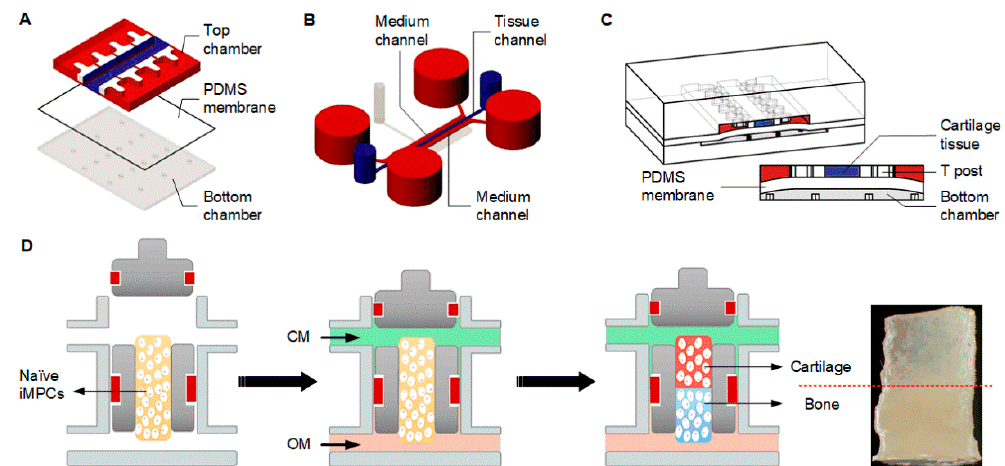
Figure 3. Schematics of cartilage- and osteochondral tissue-on-a-chip microphysiological system (MPS). ( A – C ) A cartilage-on-a-chip (COC) system. ( A ) The top and bottom chambers are separated by a polydimethylsiloxane (PDMS) membrane. ( B ) The COC top chamber has a central channel (hosting the 3D microtissues, in blue) and two side channels (for medium supplementation, in red) separated by two rows of T-shaped hanging posts (in white). ( C ) Confined hyperphysiological compression is exerted on the microtissues by pressurizing the bottom actuation compartment of the COC system. ( D ) Schematic of generating the osteochondral tissues-on-a-chip microphysiological system (MPS). After mesenchymal progenitor cells (iMPCs) are encapsulated into a hydrogel scaffold and placed into a dual flow bioreactor, chondrogenic medium (CM) and osteogenic medium (OM) are perfused through the top and bottom flow, respectively, to induce formation of the biphasic osteochondral tissue, with cartilage at the top and bone at the bottom (photographic image of the tissue shown on the right). (Reproduced with permission from Occhetta et al. [249] and Lin et al. [252].)